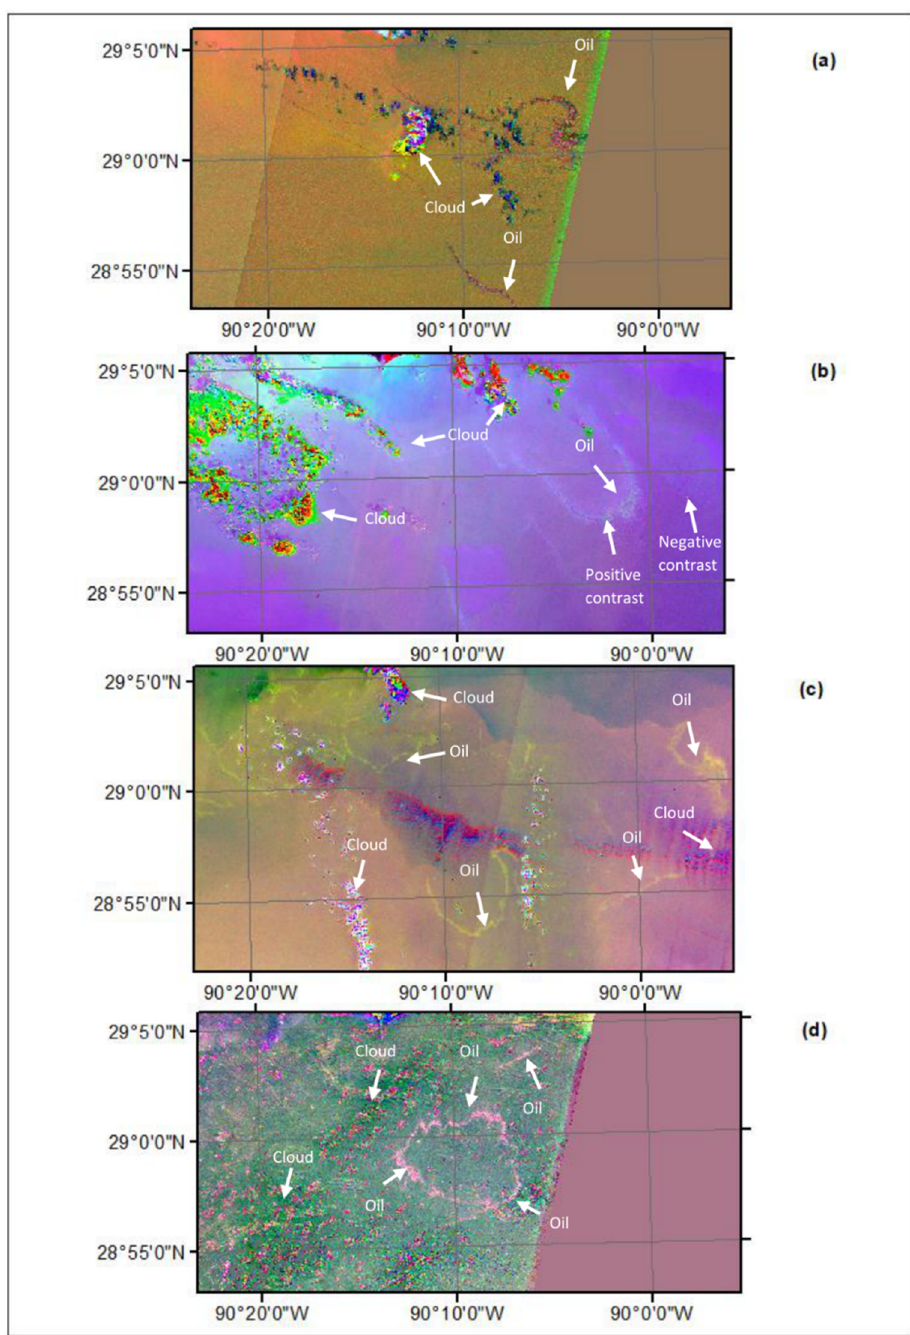
Figure 9. PCA bands RGB image. ( a ) Sentinel-2 (6, 5 and 4) bands on 2 September 2021, ( b ) Landsat- 8 (6, 4 and 3) bands on 3 September 2021, ( c ) Sentinel-2 (6, 5 and 4) bands on 4 September 2021, ( d ) Sentinel-2 (5, 8 and 12) bands on 7 September 2021.